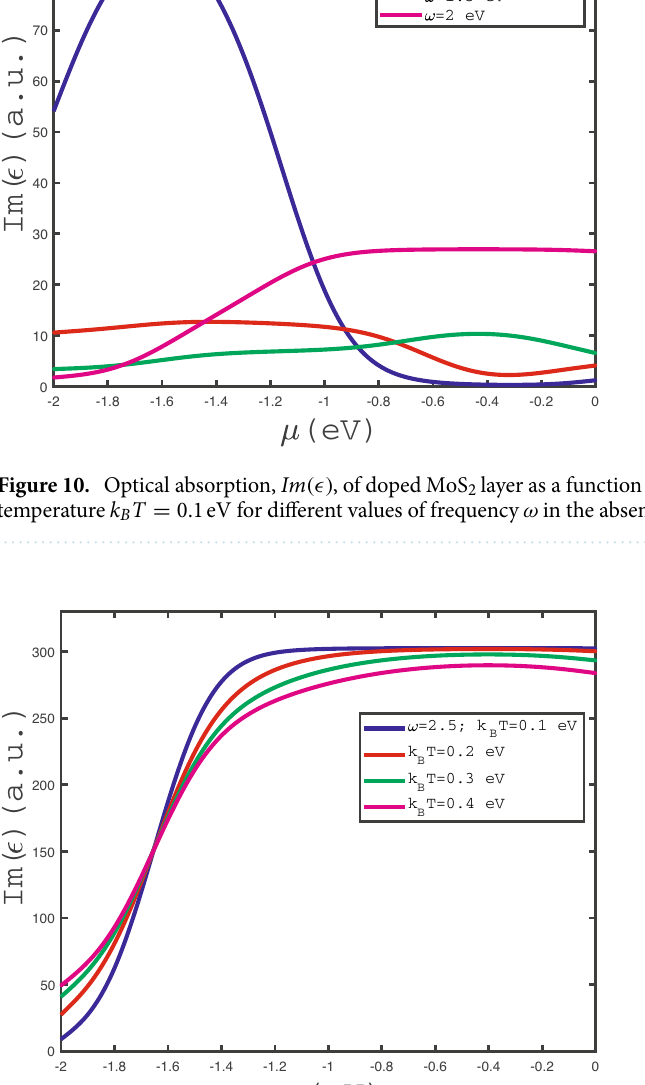
0.1 eV, 0.2 eV, 0.3 eV, 0.4 eV , in the B T =